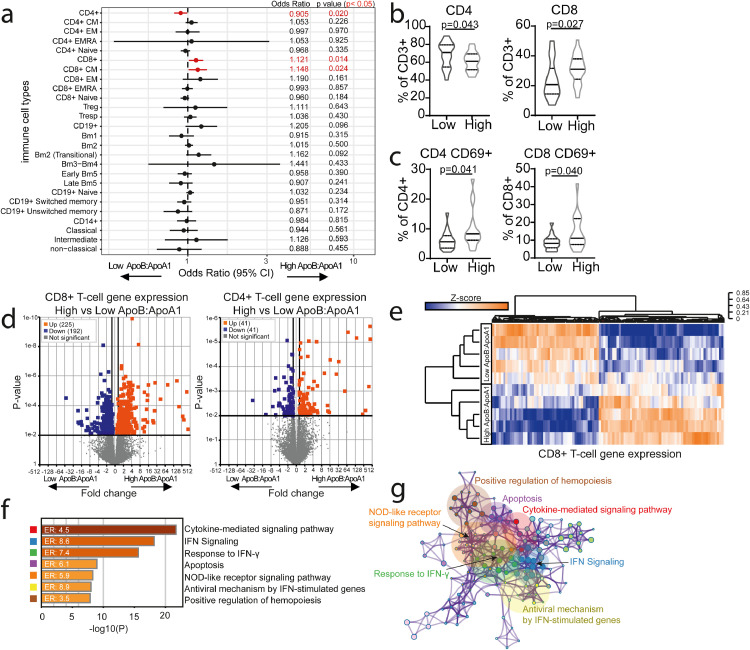
High ApoB:ApoA1 ratio patients have a unique T-cell phenotype and transcriptomic signature. Peripheral blood mononuclear cells (PBMC's) from high (n=29) and low (n=25) ApoB:ApoA1 ratio JSLE patients were stained ex-vivo to evaluate expression of 28 immune cell subsets by flow cytometry (Supplementary Fig. 1 for gating strategy). (a) Forest plot showing ORs and 95% CIs of 28 immunological parameters analysed by logistic regression adjusted for BMI, sex, age, ethnicity, disease duration, treatment, SLEDAI-2000, CRP, dsDNA, C3. Dotted line represents no effect (OR=1), statistically significant differences between high and low ApoB:ApoA1 patients (in red). iNKT and PDC data is not shown due to very different CI values. See Supplementary Data Table 2 for CIs. (b-c) Violin plots displaying CD4+ and CD8+ T-cell frequencies (b) and CD69 expression (c) between high and low ApoB:ApoA1 ratio groups. T test. FACS-sorted CD8+ (n=5/group) and CD4+ (n=6/group) T-cells from JSLE patients with high and low ApoB:ApoA1 ratio were analysed by RNA-sequencing and whole genome expression compared between the groups. (d) Volcano plots displaying fold changes and p-values, where coloured points represent statistically significantly regulated genes. (e-g) RNA-sequencing analysis for CD8+ T cells. (e) Clustered heatmap of normalised gene counts of statistically significantly altered genes with adjusted p-value threshold (<0.01) (f) Bar charts plotting cluster significance and enrichment ratio (ER) of enriched pathway ontology terms between high and low ApoB:ApoA1 JSLE patients. (g) Network diagram illustrating statistically significantly enriched genetic pathway ontology terms between high and low ApoB:ApoA1 JSLE patients. Similar terms with a high degree of redundancy were clustered into groups as depicted. Each node represents a statistically significantly enriched term, with node size proportional to the number of input genes annotated with this term. See Supplementary Fig. 8.